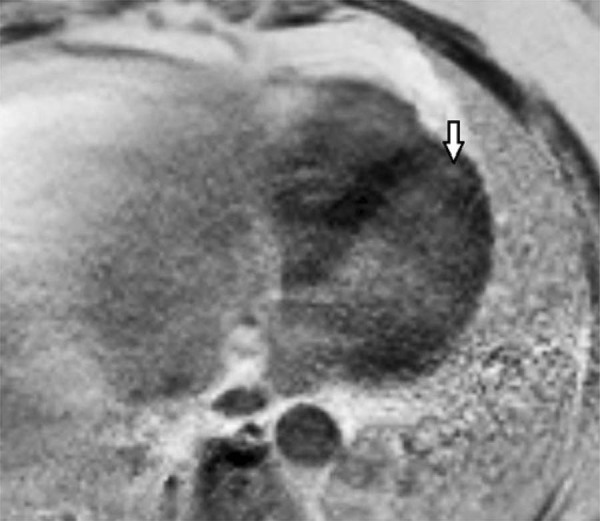
–
There is a focal lesion in four-chamber PSIR prepared gadolinium-enhanced T1-weighted image. Focal lesion localized to the apical region of the left ventricle, showing late subendocardial- myocardial enhancement compatible with fibrosis.